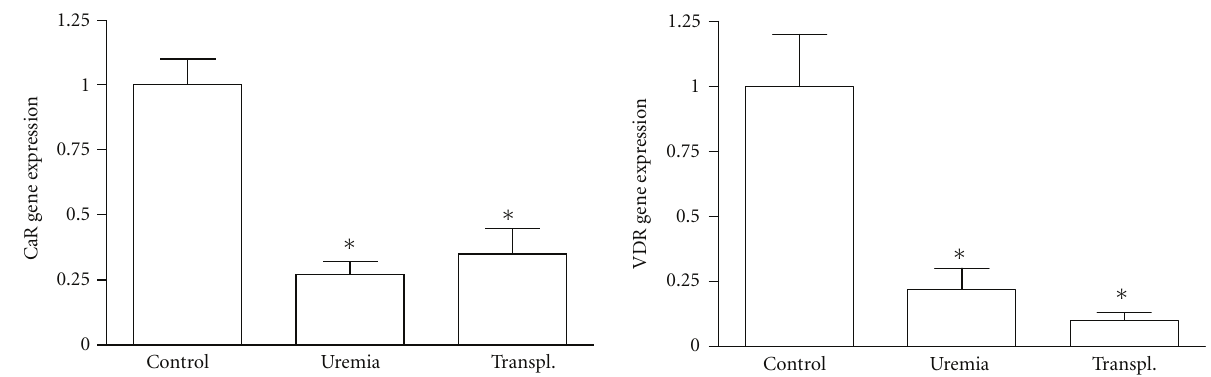
Figure 1: Downregulation of parathyroid CaR and VDR gene expression in uremia. The parathyroid calcium receptor ( CaR ) and vitamin D receptor ( VDR ) were significantly downregulated in long-term uremic rats with severe secondary hyperparathyroidism. ∗ P < 0 . 005. Modified from [7], with